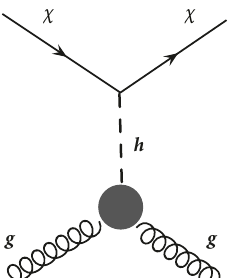
Figure 2: The main interaction between the neutralino and heavy nuclei in underground detectors in the limit of squarks and heavy Higgsbosonsbeingmuchheavierthan 𝑚 ℎ = 125 GeVandingeneral outside of LHC reach.